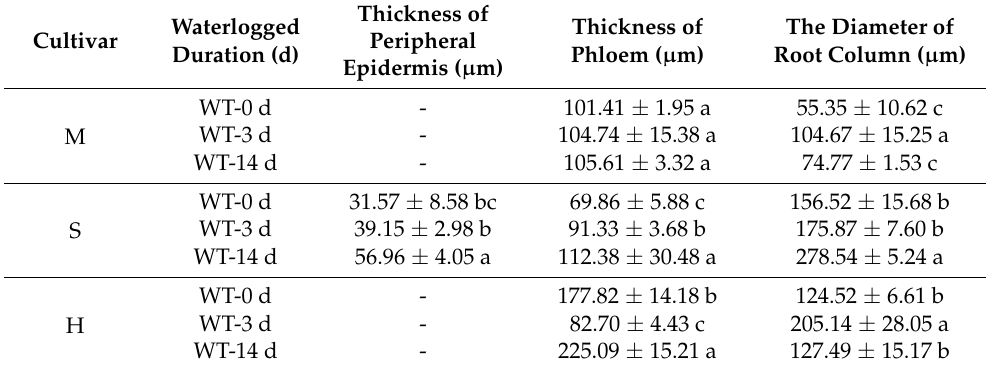
Table 4. Anatomical characteristics of the fine roots of different peach rootstocks under waterlog- ging stress.